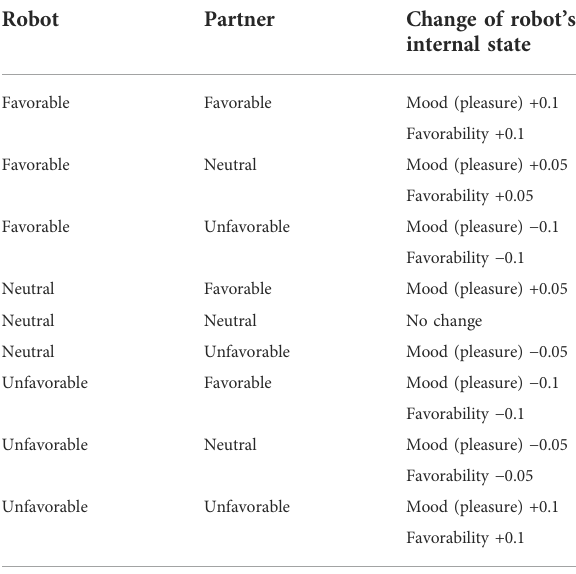
TABLE 2 Robot ’ s favorability change owing to both robot and partner ’ s interest in the current topic.